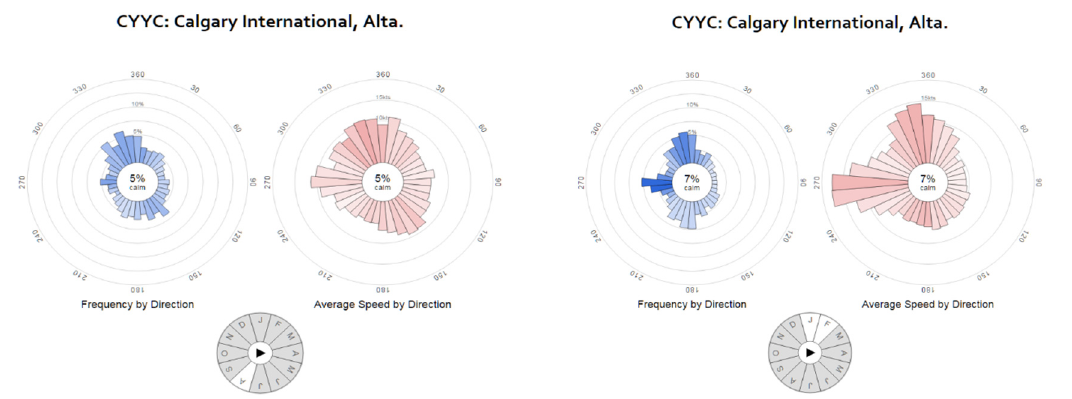
Figure 4. Calgary summer and winter prevailing winds (from http://windhistory.com [50]).